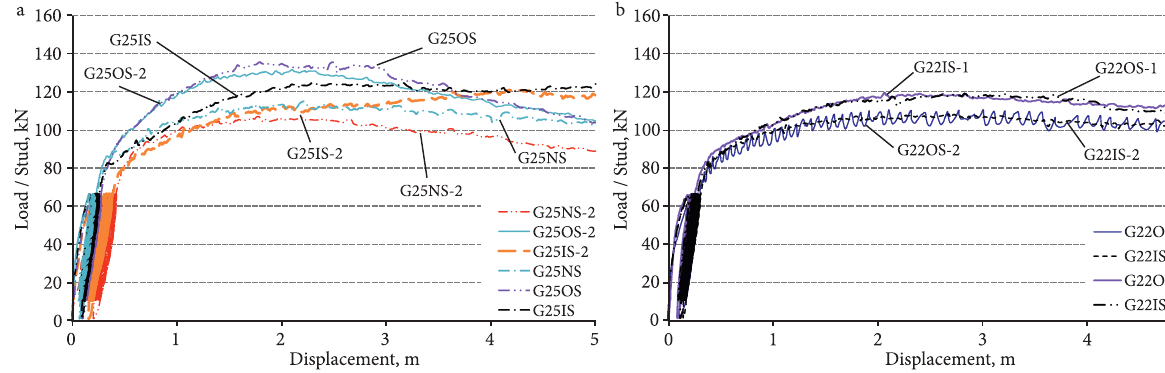
Fig. 6. Load-slip curves according to strengthening details: a – 25 mm stud – 3 d s , 5 d s ; b – 22 mm stud – 3 d s , 4 d